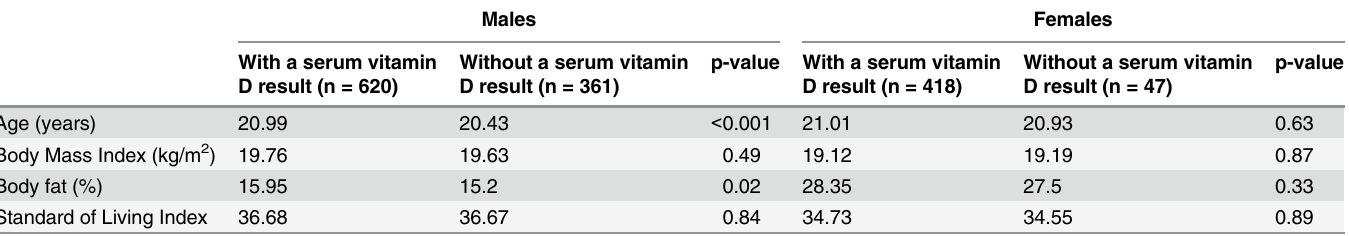
Table 1. Key characteristics of APCAPS participants with a serum vitamin D result (n = 1038) compared to APCAPS participants without a serum vitamin D result (n = 408); 2009 –